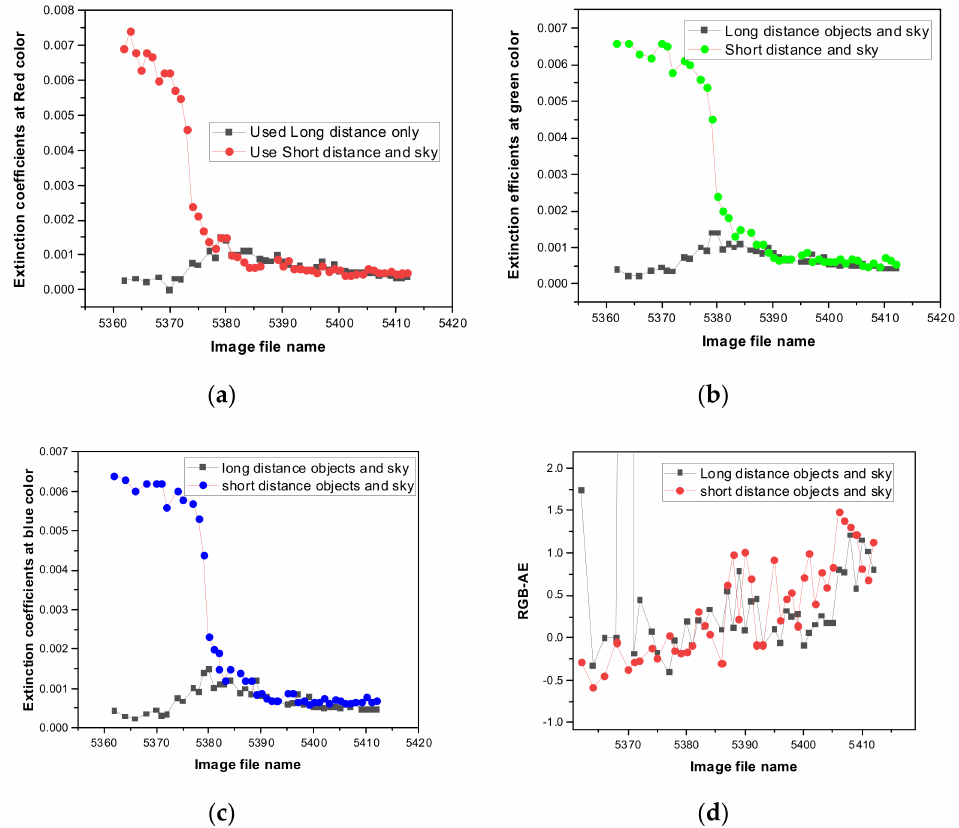
Figure 6. Extinction coefficients and RGB-AE obtained on a foggy day using objects at various distances. ( a ) Extinction coefficient shown in red, ( b ) extinction coefficient in green, ( c ) extinction coefficient in blue, and ( d )